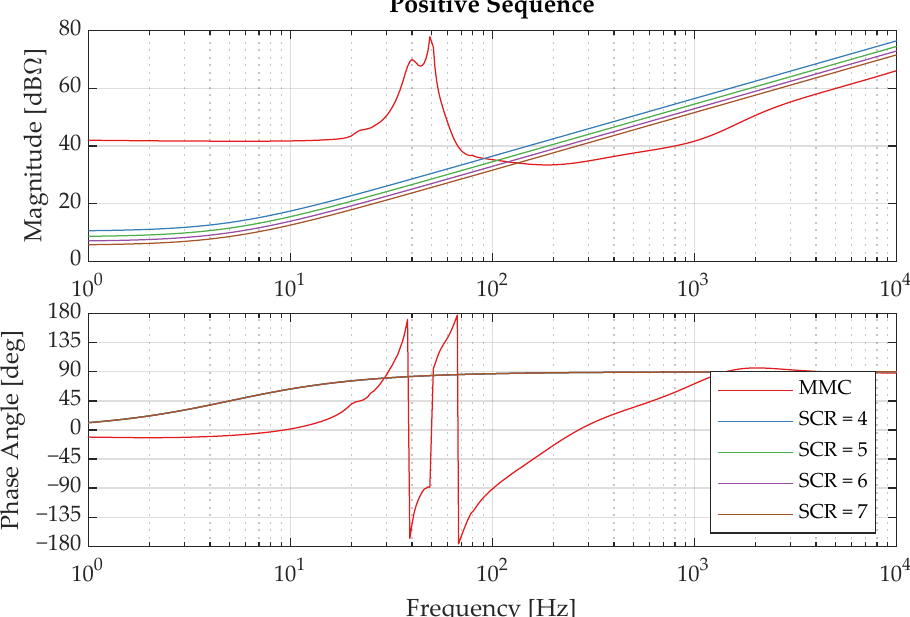
Figure 7. MMC impedance and AC grid impedance for different SCRs.